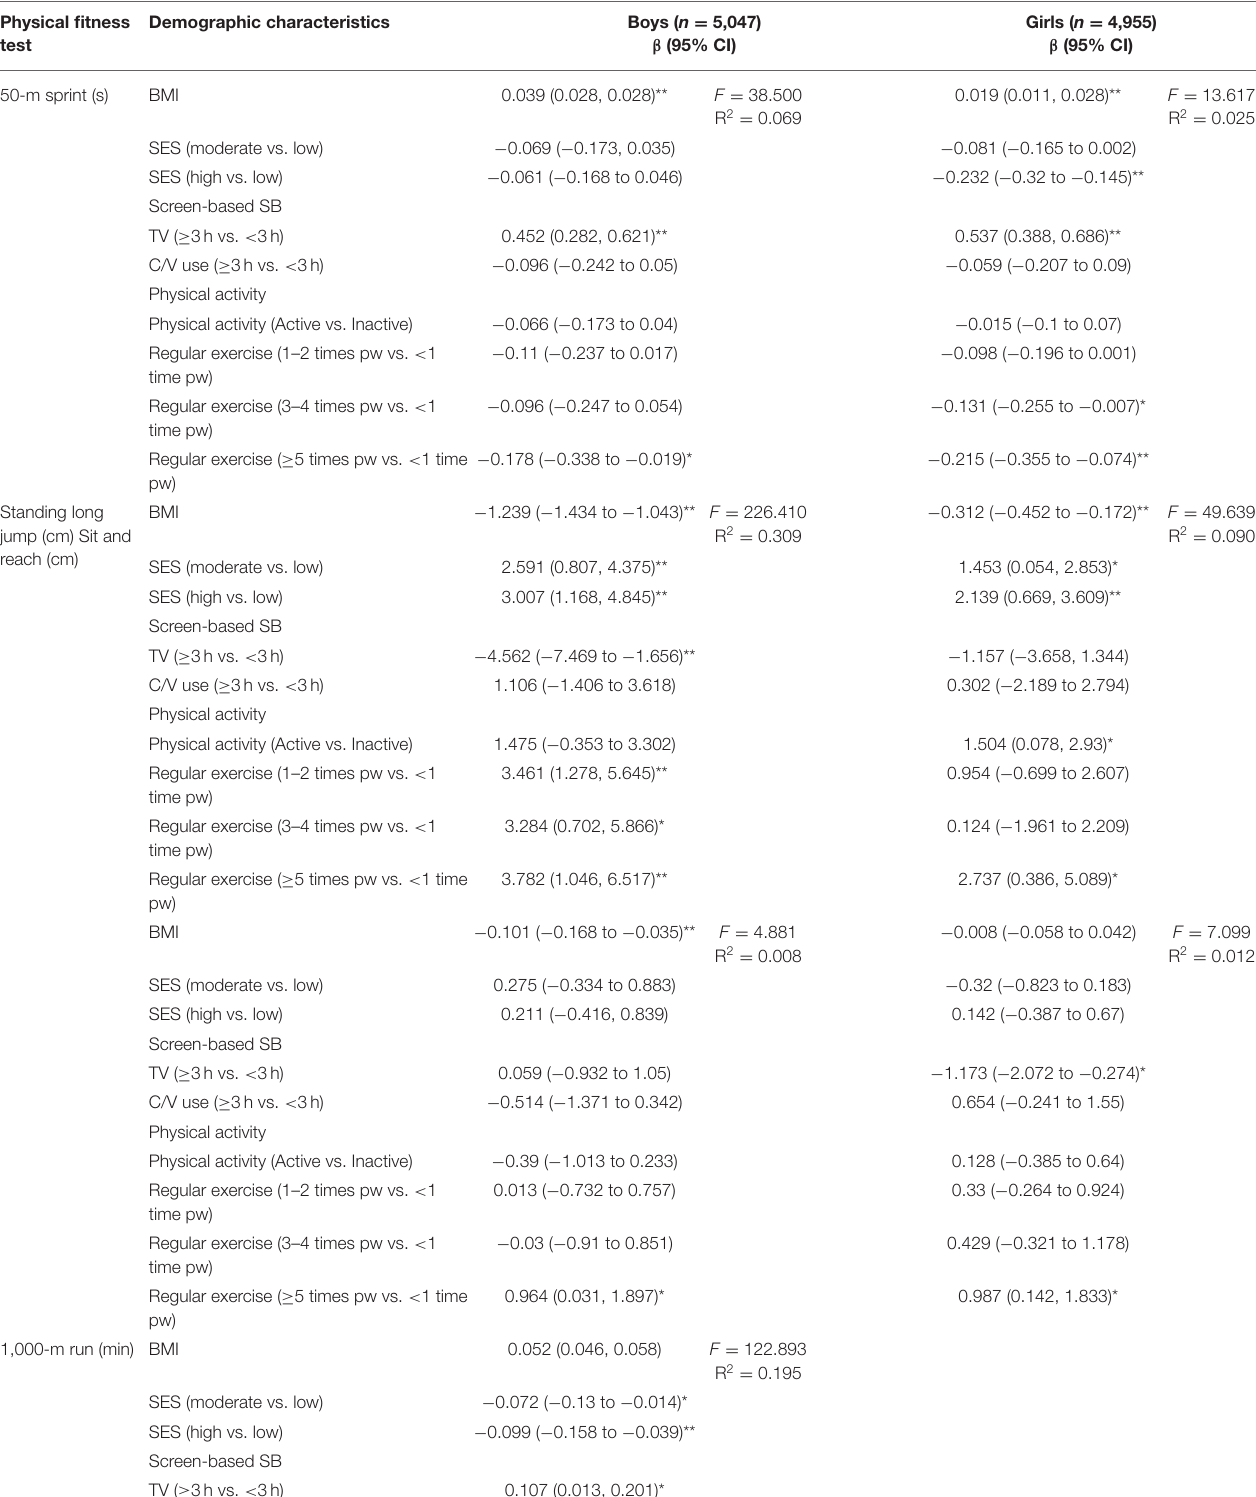
TABLE 2 | Multivariable General Linear Models Evaluating the Association of Physical Activity and Screen-based Sedentary Behavior and Demographic Factors and Physical Fitness. Physical fitness